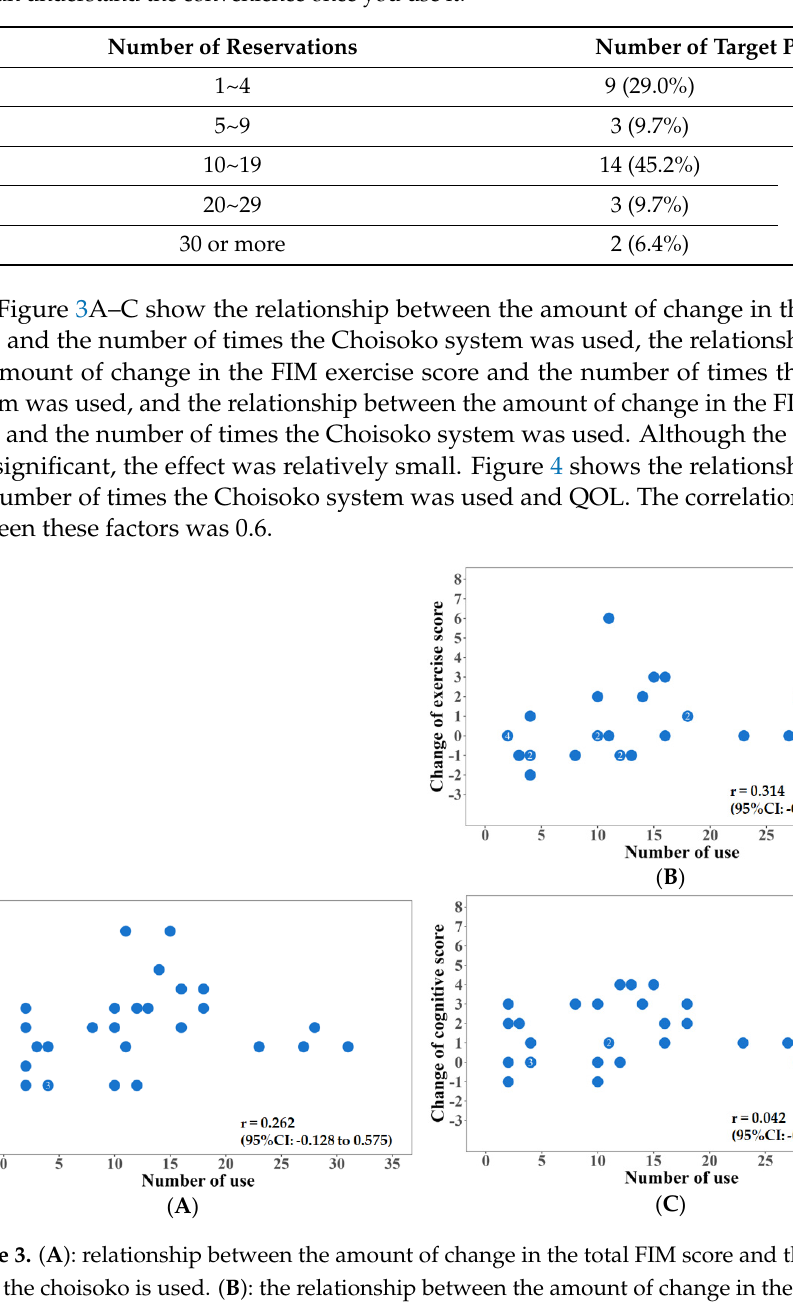
Table 3. Percentage of reservations per person. n = 31, high percentage of multiple users, because you can understand the convenience once you use it.